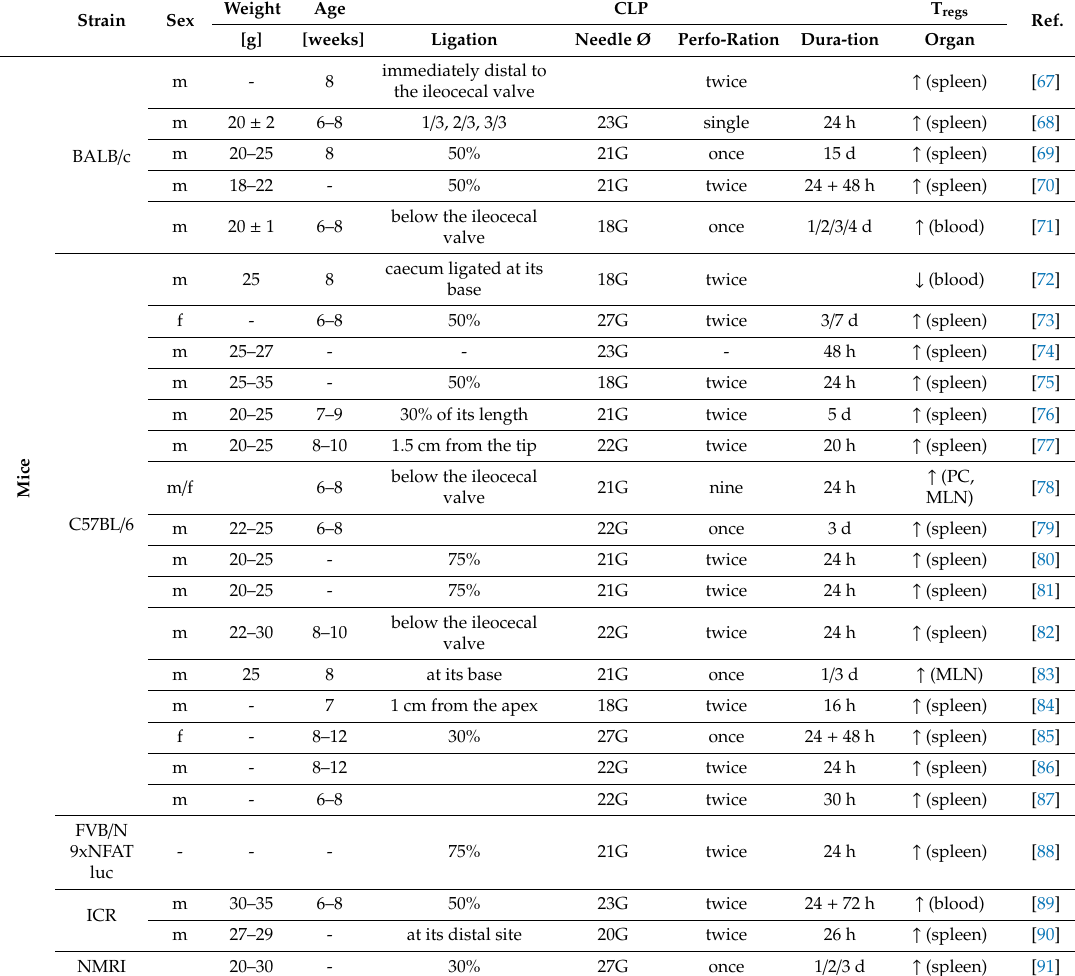
Table 1. Polymicrobial sepsis induced by a cecal ligation and puncture (CLP) operation in mice and rats increased regulatory T cell (T reg ) count in the blood and spleen. Di ff erent mouse and rat strains have been used. The severity of the model is a ff ected by the needle diameter, the number of punctures, and the ligation length [64,65]. (Ø, diameter; CLP, cecal ligation and puncture; f, female; G, gauge; m, male; MLN, mesenteric lymph nodes; and PC, peritoneal cavity.) Weight Age Strain Sex Perfo-Ration Dura-tion